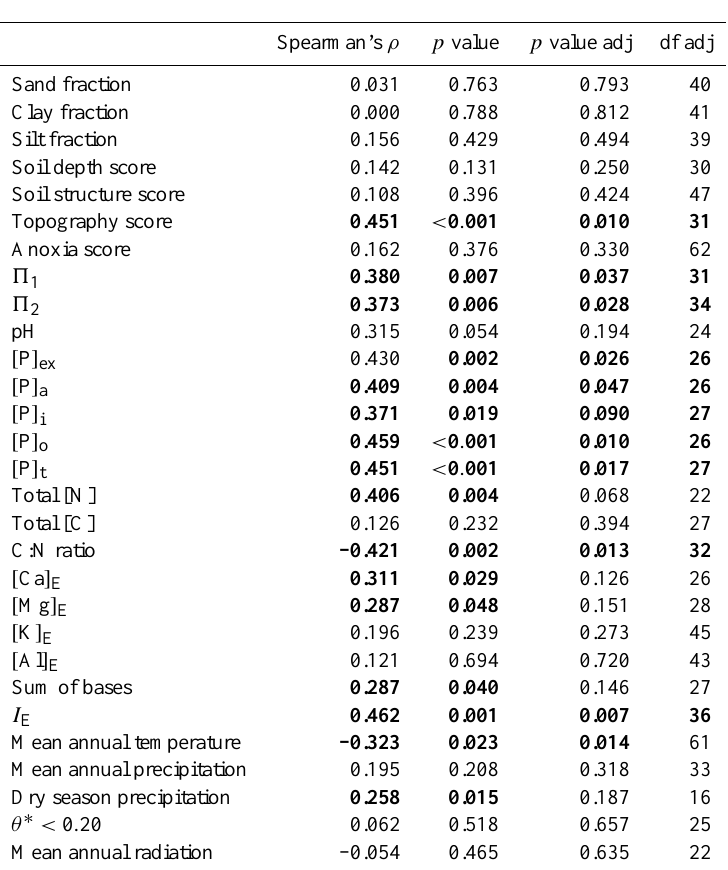
Table 1. Spearman’s ρ for relationships between above-ground coarse wood production and a range of soil and climate predictors. Probabil- ities ( p ) are given with and without adjustment (adj) for degrees of freedom (df) according to Dutillieul (1993). Abbreviations used: 5 1 and 5 2 – first and second indices of soil physical conditions (Sect. 2.2); [ P ] ex , [ P ] a , [ P ] i , [ P ] o , [ P ] t – extractable, available, inorganic, organic, and total soil phosphorus pools; [ Ca ] E , [ Mg ] E , [ K ] E , [ Al ] E - exchangeable calcium, magnesium, potassium and aluminium concentrations; I E - effective soil cation exchange capacity; θ ∗ < 0 . 20 – modelled number of months with soil water less than 0.2 of maximum available soil water content. Where p ≤ 0 . 050 values are shown in